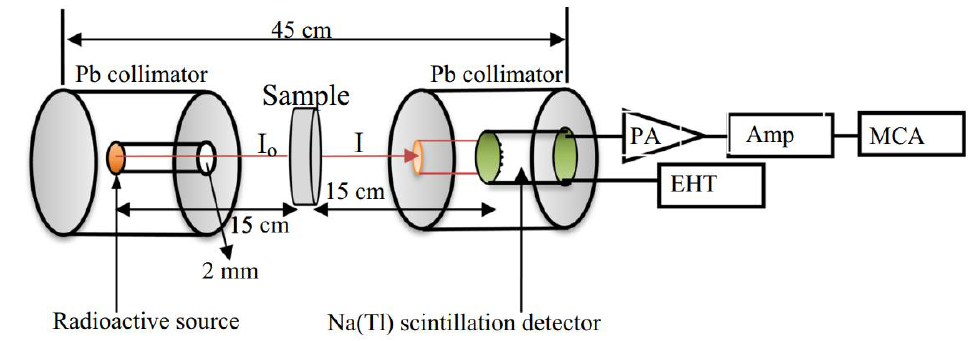
Figure 1. Experimental setup of gamma shielding measurements.